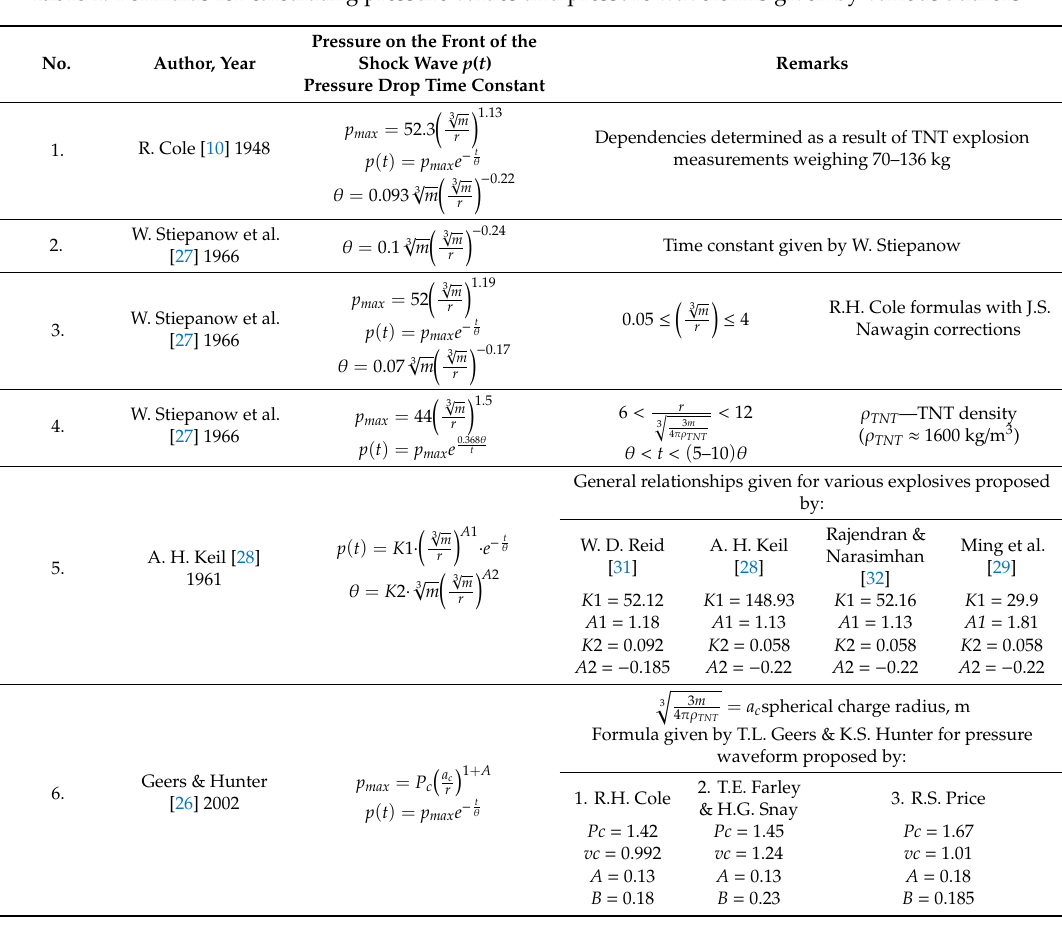
Table 1. Formulas for calculating pressure values and pressure waveforms given by various